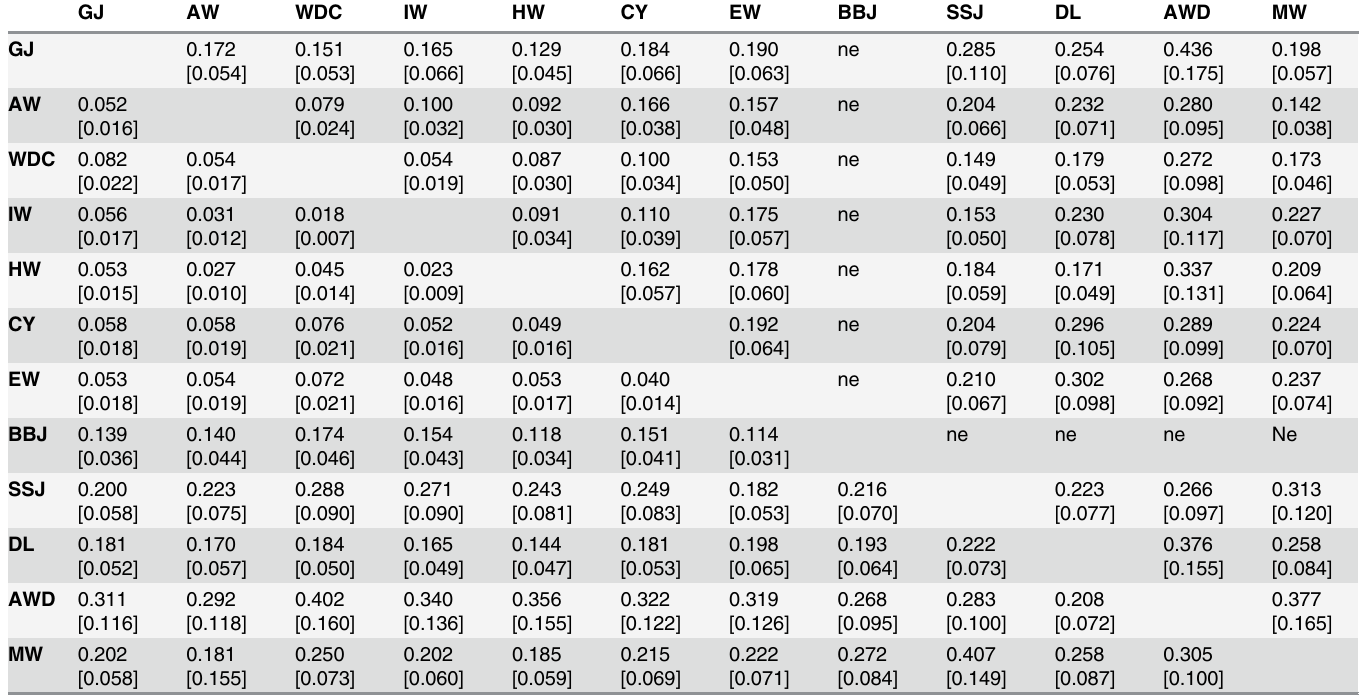
Table 3. Mean Tamura-Nei + G genetic distances among the main Canis lineages and other wolf-like canids, estimated from cytochrome b (below diagonal) and control region (above diagonal) sequences. Values in square brackets represent standard error estimates. Depicted taxa include golden jackal (GJ), African wolf (AW), wolf-dog clade (WDC), Indian wolf (IW), Himalayan wolf (HW), coyote (CY), Ethiopian wolf (EW), black-backed jackal (BBJ), side-striped jackal (SSJ), dhole (DL), African wild dog (AWD) and maned wolf (MW). Distance not estimated (ne) as CR sequence of BBJ is not available. GJ